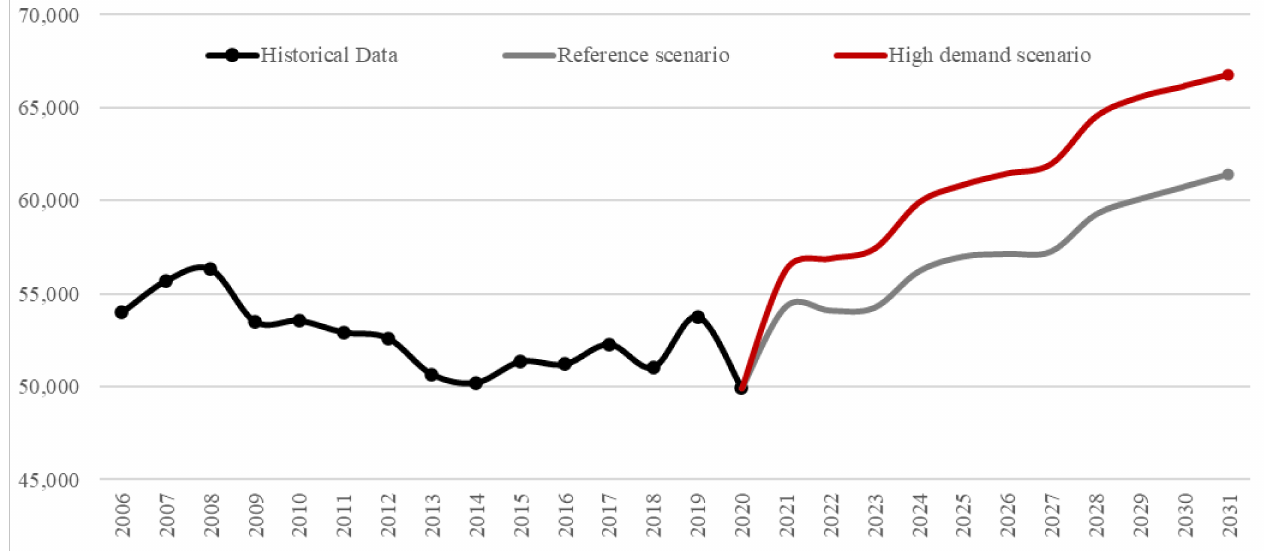
Figure 5. Historical Data and Forecast of Total Annual Demand for Electricity in Greece (GWh), (2006–2031), Source: Hellenic Transmission System Operator and Authors’